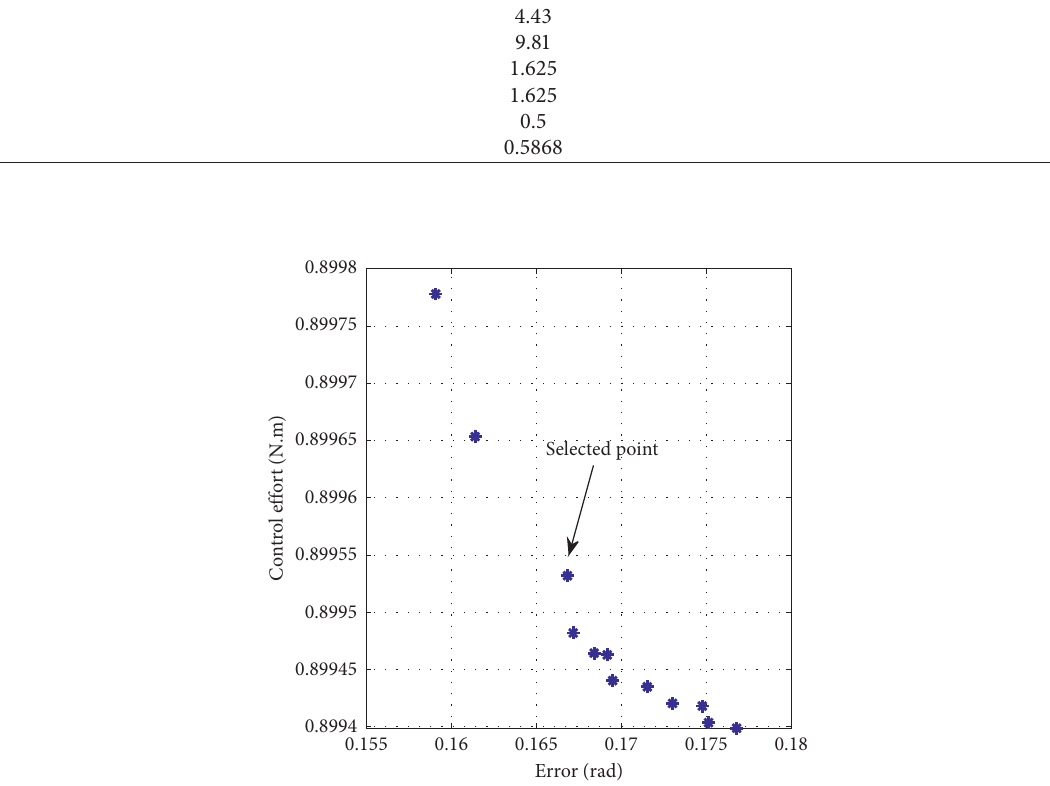
Figure 4: Pareto front obtained by the multiobjective algorithm related to the proposed fuzzy adaptive sliding mode-based feedback linearization controller.